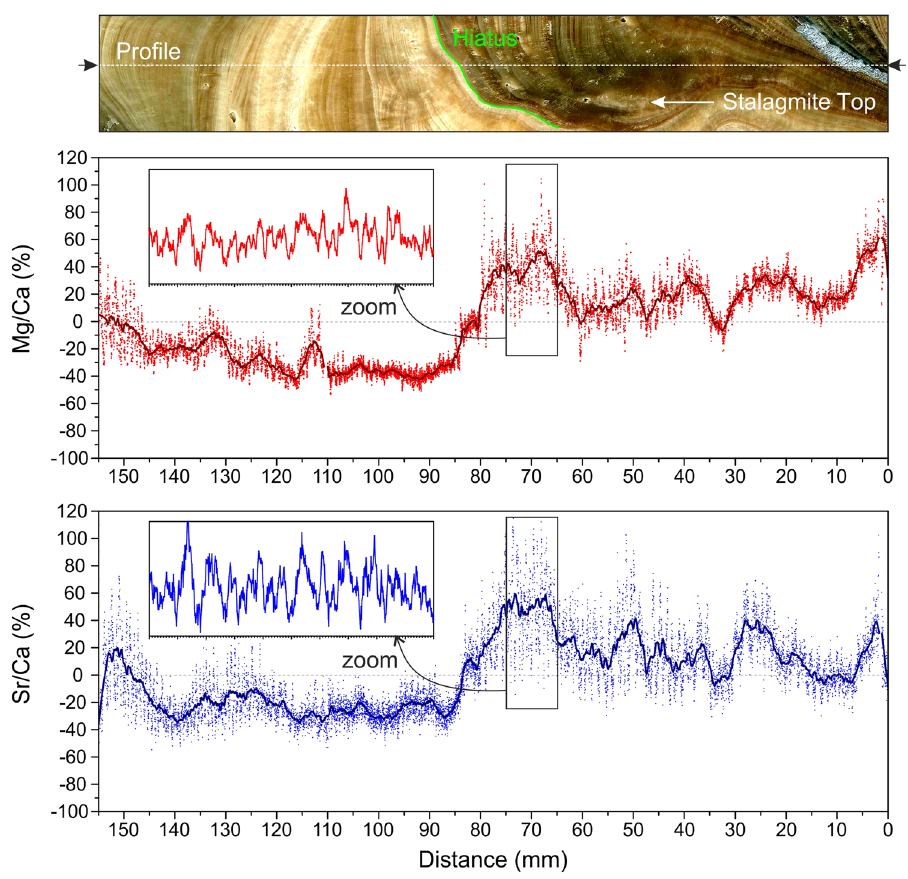
Figure 4. 1-D data series showing relative variations in Sr/Ca and Mg/Ca (expressed in %) along the growing axis of the speleothem through the selected axial profile (indicated by the dotted line). Note that a non- depositional hiatus produces a major drop in the 1-D series of both the Mg/Ca and Sr/Ca